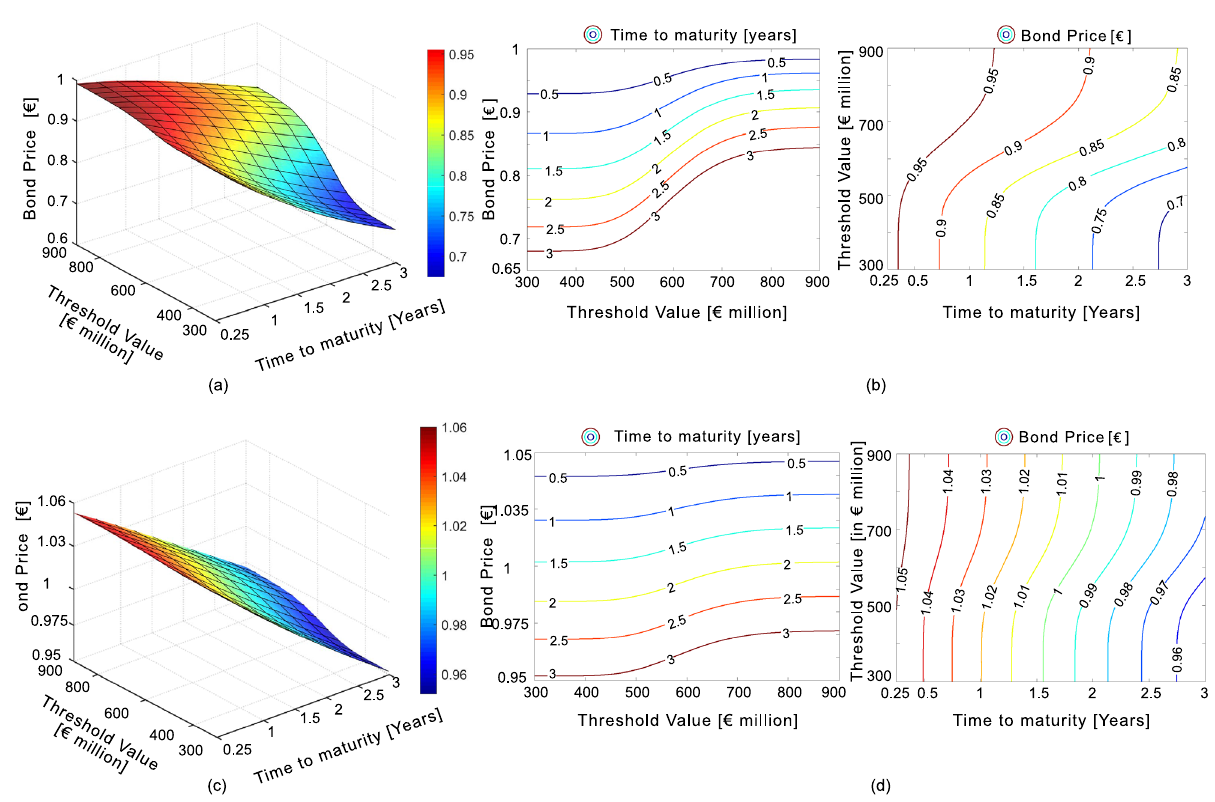
Figure 6. Zero-coupon CAT bond pricing: ( a ) surface plot of bond price for various T − D levels; ( b ) left: contour plot of threshold versus bond price (each contour line refers to different time to maturity levels); right: contour plot of time to maturity versus threshold value (each contour line refers to different bond price levels); Coupon CAT bond pricing: ( c ) surface plot of bond price for various T − D levels; ( d ) left: contour plot of threshold versus bond price (each contour line refers to different time to maturity levels); right: contour plot of time to maturity versus threshold value (each contour line refers to different bond price levels).